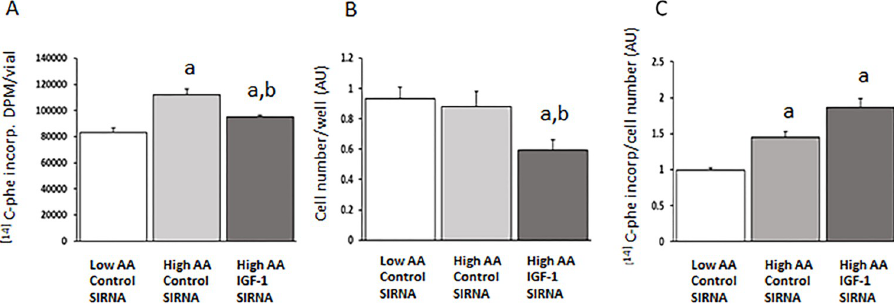
Fig 2. A-C. 2A. Refeed L6 skeletal muscle cells in media with High AA concentration (9 mM) showed increased phenylalanine incorporation rates by 35% in siRNA control cells; but only 14% in IGF-1 knockdown cells compared